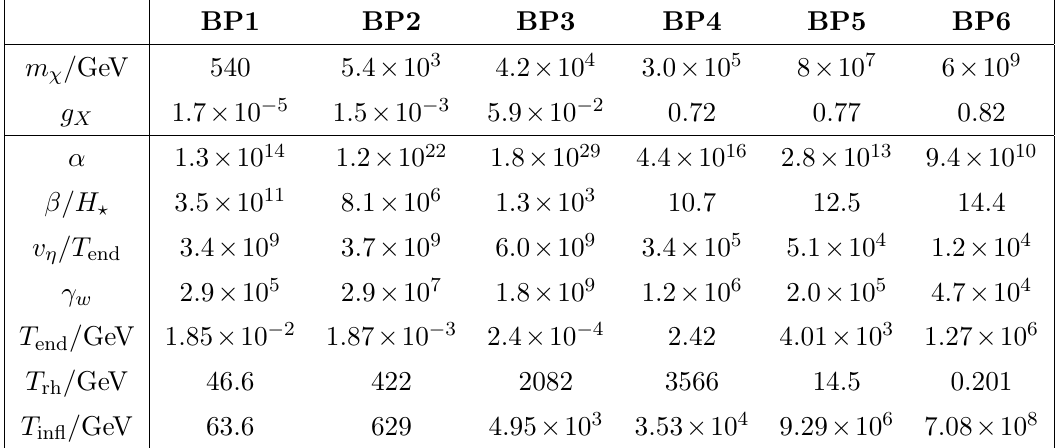
Table 2 . Benchmark points for the SU(2) X Model that give Ω DM h 2 = 0 . 11 . Note that T ? = T infl